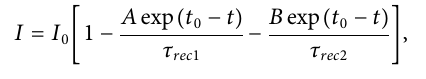
Frontiers in Physics |